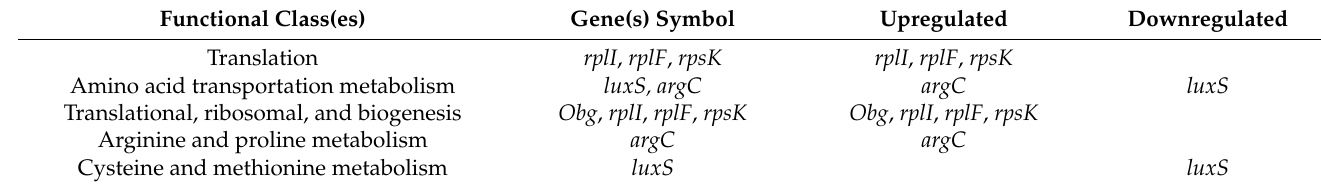
Table 2. Functional classes with associated upregulated and downregulated genes in control (C) vs. eugenol (E).